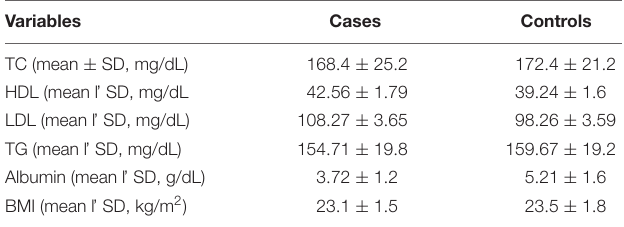
TABLE 3 | Clinical variables assessed in cases and